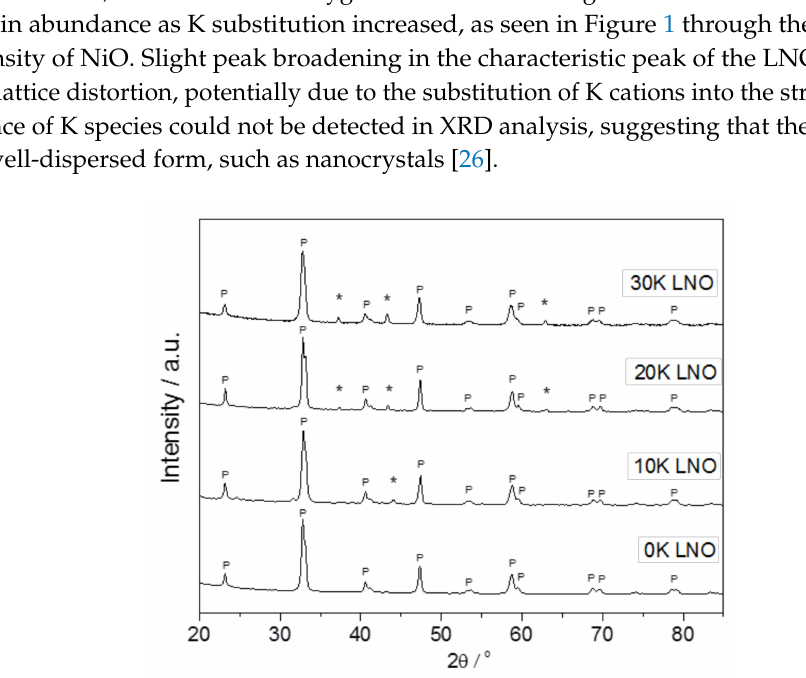
Figure 1. Characteristic peak intensity normalized XRD patterns of 0–30K LNO catalysts. The (*) symbol represents the NiO standard phase while (P) symbol represents the LaNiO 3 perovskite phase.